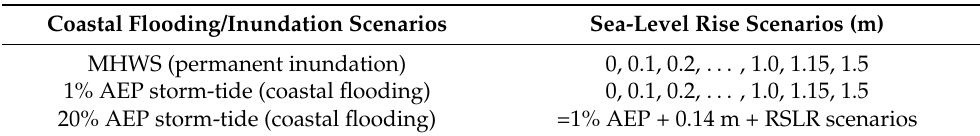
Table 2. Coastal flooding and inundation scenarios modelled. RSLR in metres relative to present-day MSL. Timing for RSLR scenarios is provided in Table 3.